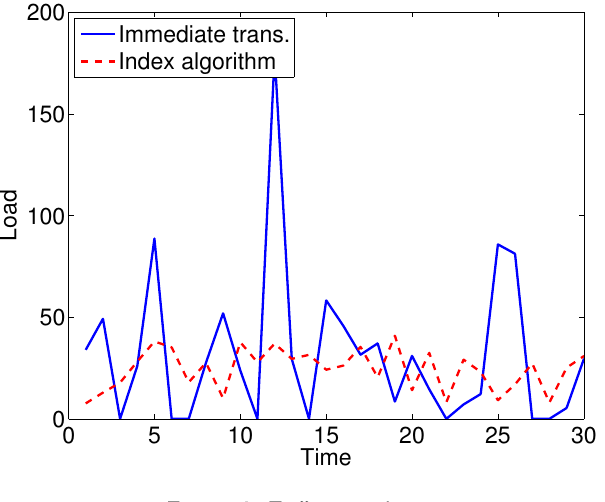
Figure 5. Percentage of Jobs Missed Deadline when Index Policy Objective is Minimizing Missed Deadlines, Synthetic Trace